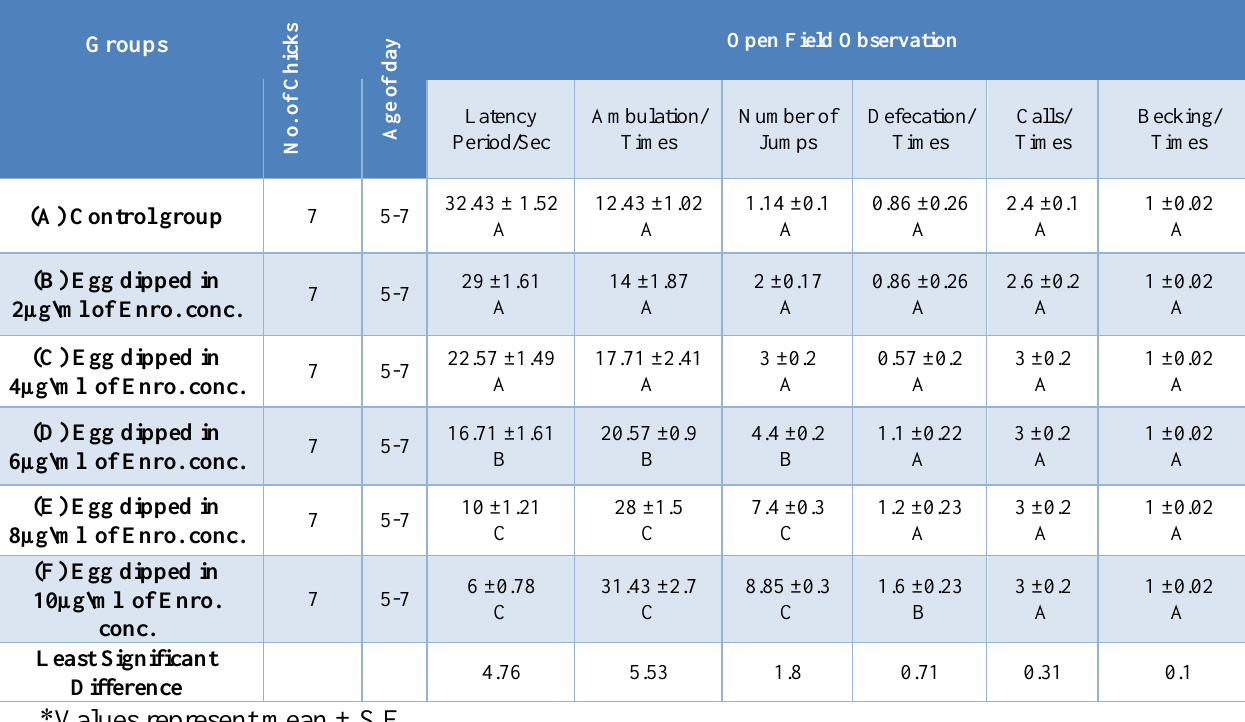
Table, 2: Open field Observations of newly hatched chicks whose eggs were dipped in different concentrations of Enrofloxacin. Groups